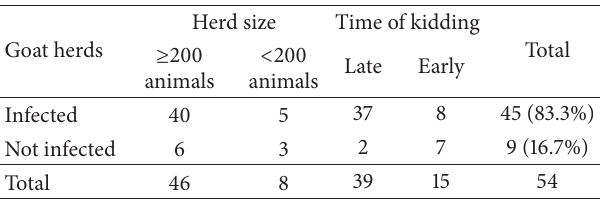
Table 1: Prevalence (%) of Cryptosporidium spp. infection in goat herds related to their size and time of